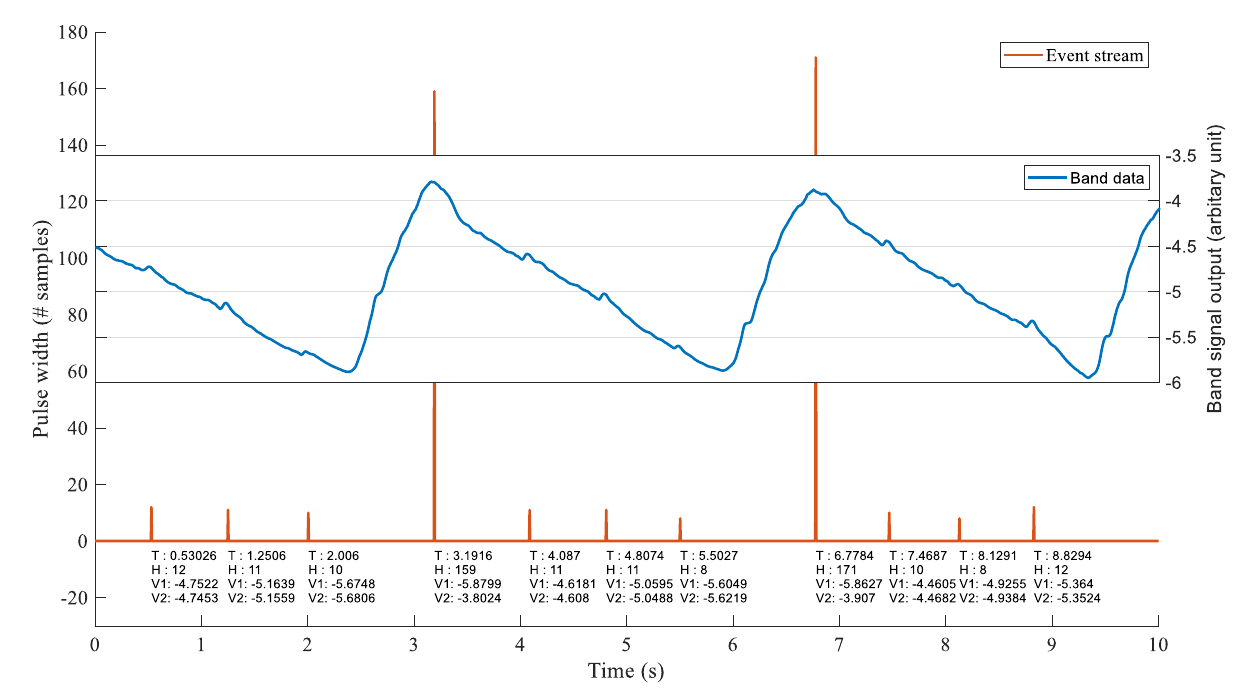
Figure 7. Events produced by the event-generating step of the algorithm. Each event has an associated timestamp (T), event period (H), band signal amplitude at the beginning (V1), and end of the event (V2).